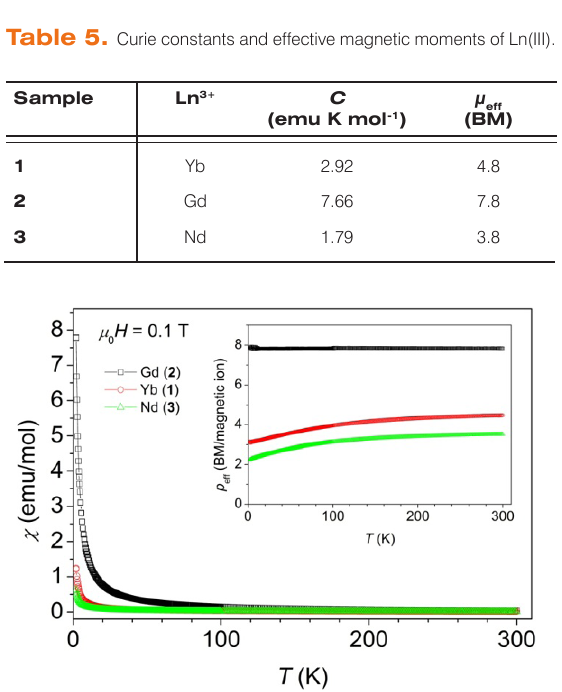
Figure 6. Molar susceptibility as a function of temperature measured in a magnetic field of 0.1 T. Inset shows an effective magnetic moment as a function of temperature calculated per magnetic